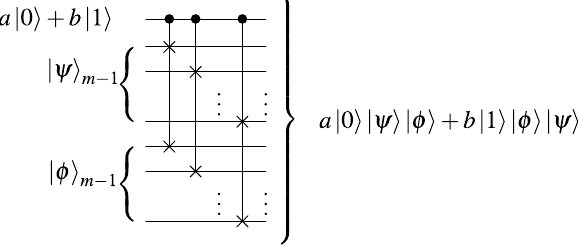
Figure 3. Combining states with controlled-swap